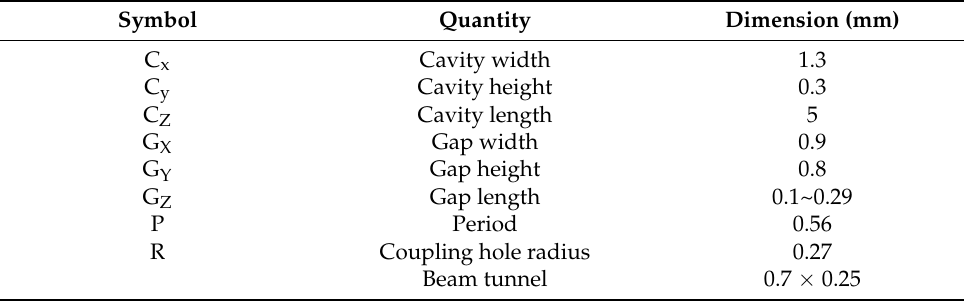
Figure 3. Structure of the designed THz EIO circuit. Table 1. EIO dimensions.